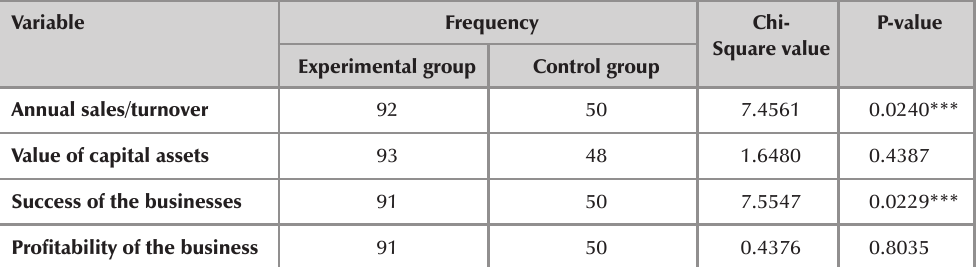
Chi-square test: Comparison of the experimental and control groups regarding their business performance